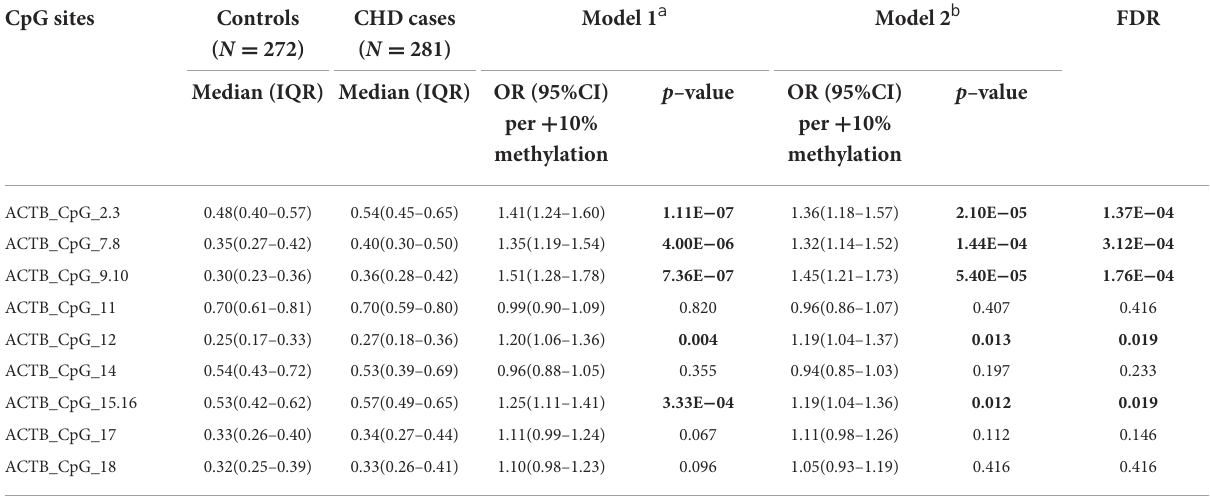
TABLE 2 Methylation difference of ACTB between CHD cases and